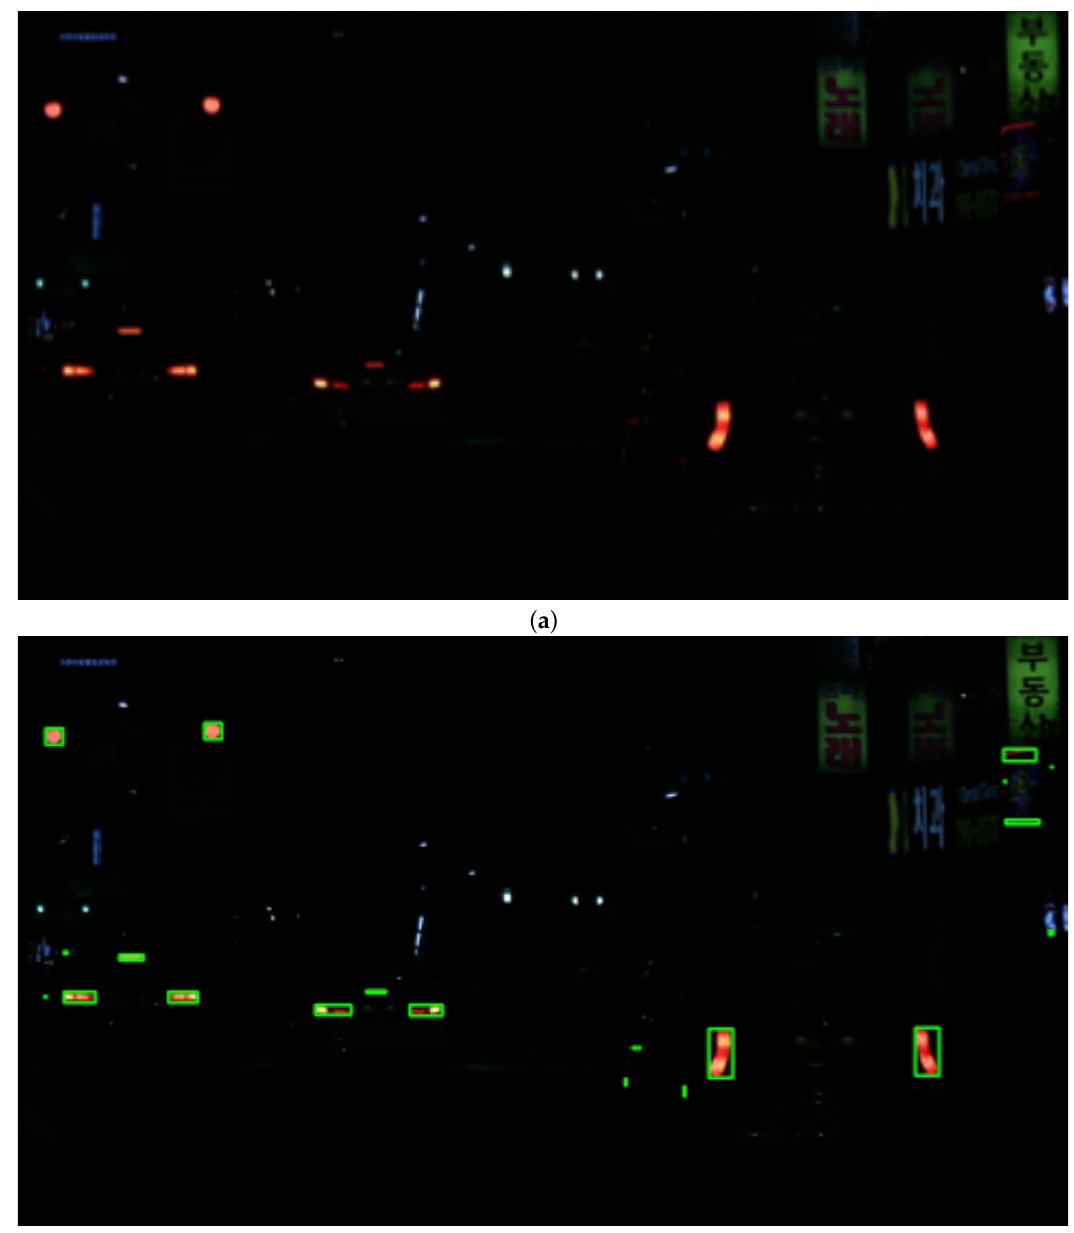
Figure 9. Result of the generation phase: ( a ) input image; ( b ) output